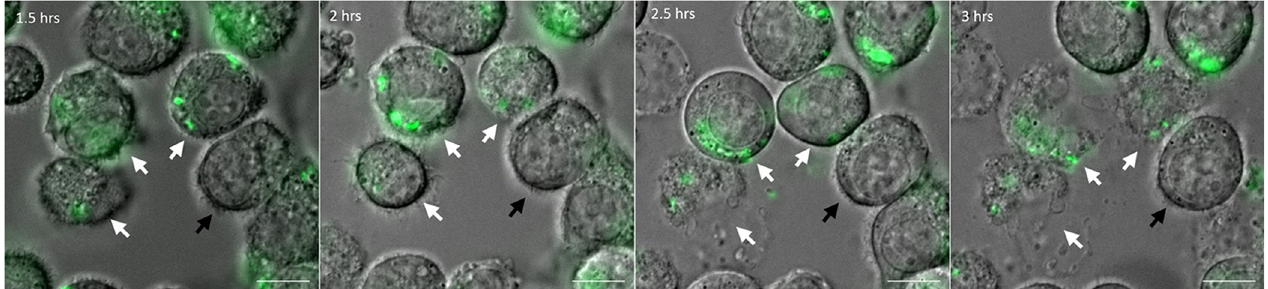
Fig 1. Live imaging of macrophages infected with P . aeruginosa . J774 macrophages were infected with PAO1 wild-type (WT) strain expressing GFP. Time lapse imaging was started at 1.5 hrs post-phagocytosis. Cells were maintained in DMEM supplemented with gentamicin at 37˚C and 5% CO 2 throughout imaging. White arrows point at the cells that harbor intracellular bacteria and undergo lysis between 1.5 hrs and 3 hrs post-phagocytosis. Black arrow shows an uninfected and unlysed cell. Scale bar is equivalent to 10 μ m.